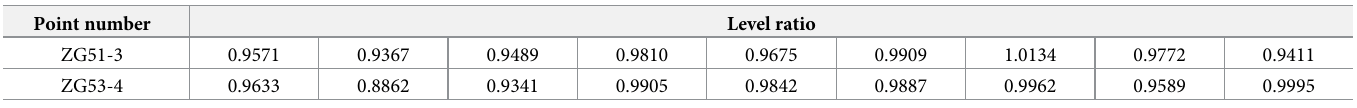
Table 3. Raw data level